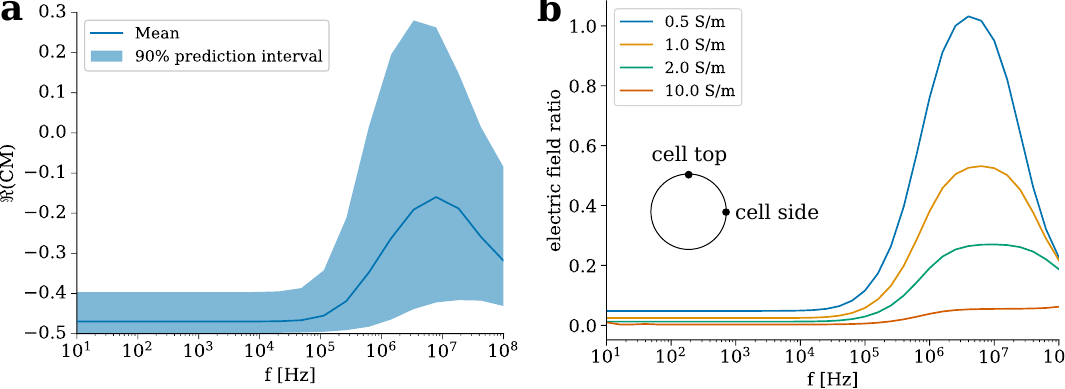
Figure 7. ( a ) Mean value and 90% prediction interval for the real part of the CM factor, (cid:60) ( CM ) . ( b ) Ratio between the field at the top and at the side of a cell, which is centred in the hydrogel, for different conductivities. This means that the field is always greater at the side of the cell when the ratio is less than